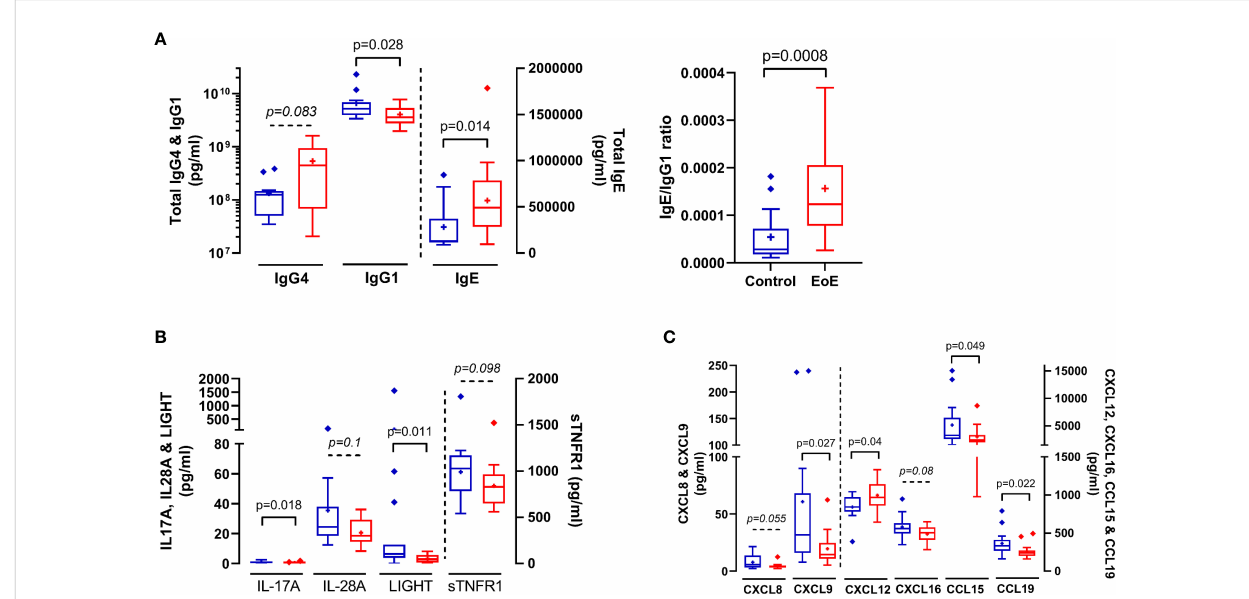
FIGURE 4 Immune soluble components in plasma that signi fi cantly (p < 0.05) or trend (0.05 < p < 0.1) to discriminate (VIP > 1) between EoE patients (red bars) and controls (blue bars): Total IgE, IgG1 and IgG4 (A) , cytokines (B) and chemokines (C) concentrations in plasma. IgE/IgG1 ratio is also shown in (A) P values obtained through Mann-Whitney tests are